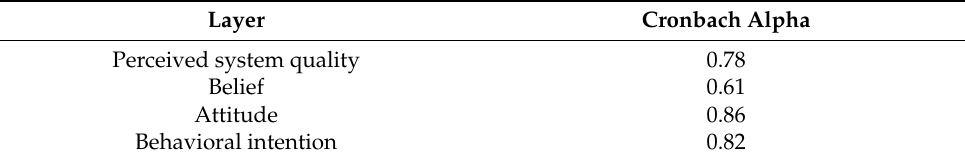
Table 7. Cronbach’s alpha results of the post-test questionnaire